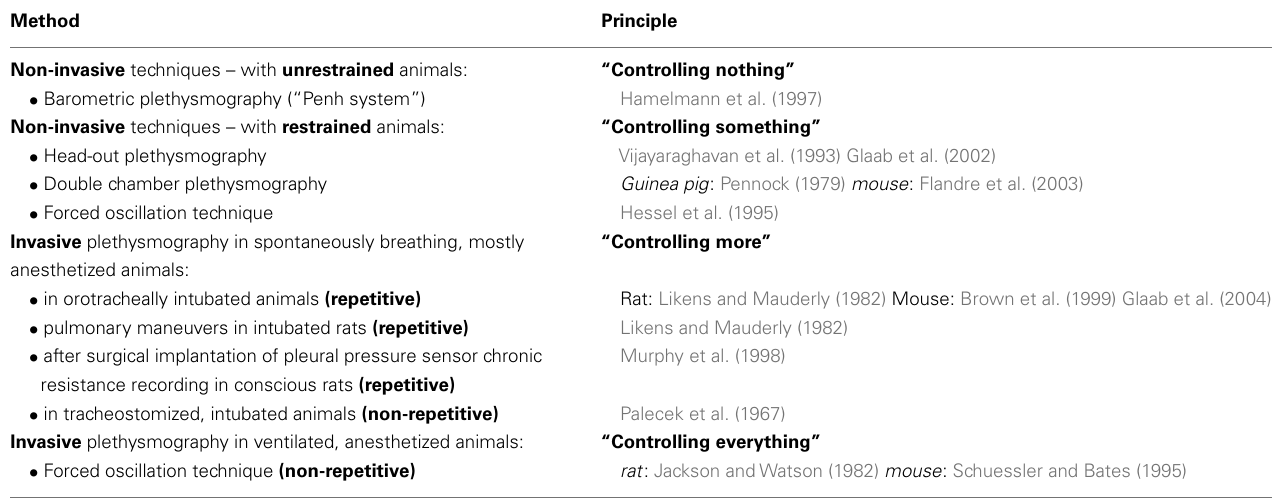
Table 1 | Short overview of in vivo methods used to measure lung function in